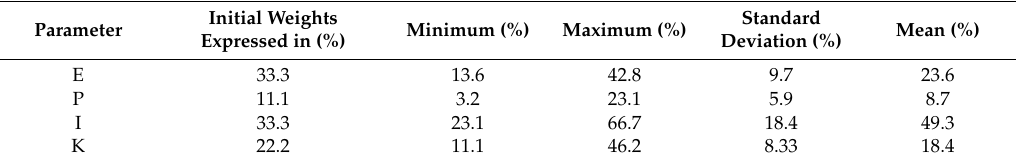
Table 2. Sensitivity analysis for Epikarst, Protective Cover, Infiltration Conditions and Degree of Karstic Network Development (EPIK) parameters.